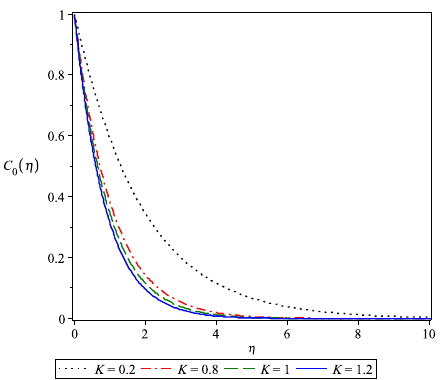
Figure 7. Dependency of concentration profile C 0 on the chemical reaction parameter K when N = 0.8 and Sc =